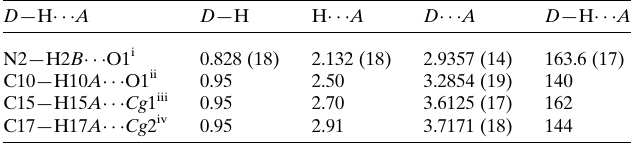
Table 1 Hydrogen-bond geometry (A˚ , (cid:3) ).